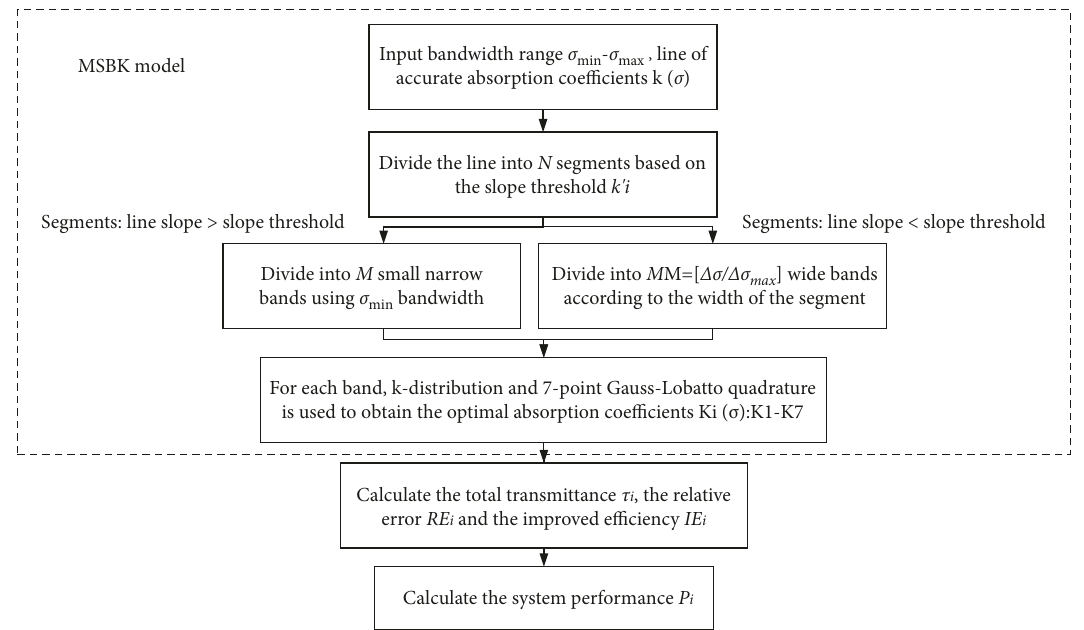
Figure 2: Flow chart of system performance